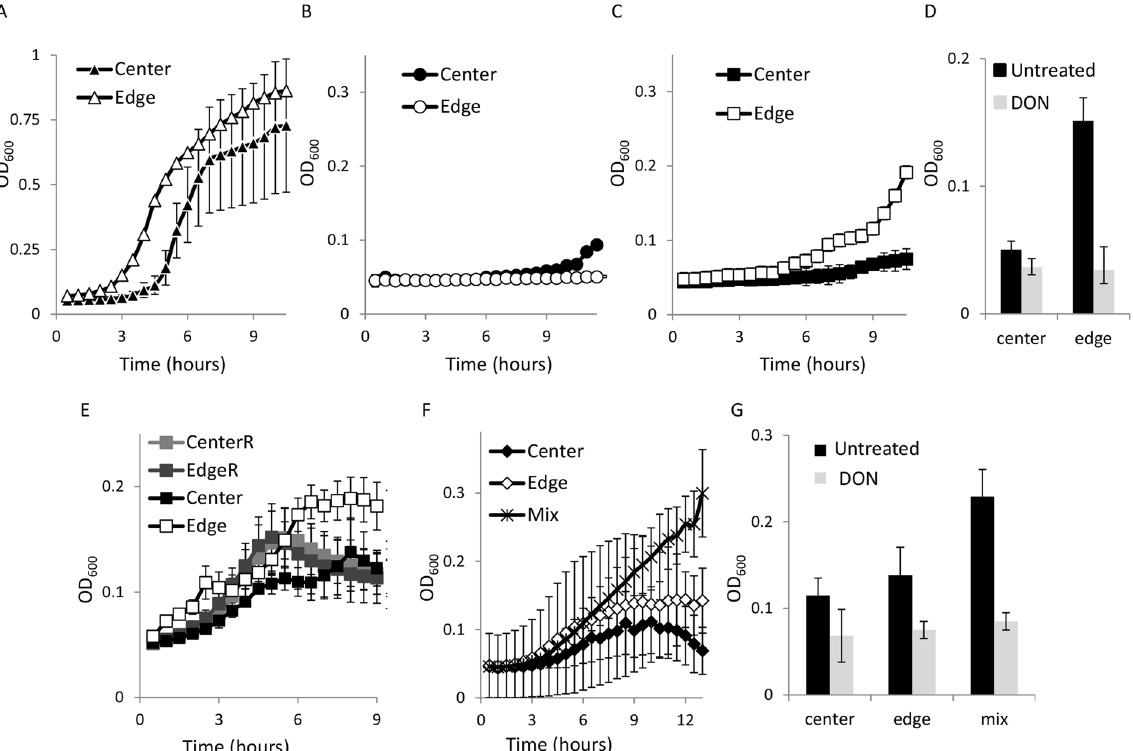
Figure 4. Spatial adaptation of biofilm cells to glutamate utilization. ( A – C ) Cells were harvested from developed biofilms indicated areas into PBS buffer, and gently sonicated. The cell counts were normalized by spectrophotometer . Harvested cells were inoculated in different media to assess planktonic growth by measuring OD 600 in a microplate reader. ( A ) Tryptic Soy Broth (TSB) rich medium (Difco). ( B ) MS salts applied with glutamate where it serves as the sole carbon and primary nitrogen source. ( C ) MS medium with ammonium chloride as a nitrogen source and sodium lactate as a carbon source (0.5%). When grown on glutamate or sodium-lactate, the periphery (edge) samples differed from the center interior samples by P– values < 0.0001 and < 0.001 respectively by a two tailed t-test. Results are an average of a single experiment performed with five independent technical repeats. Errors bars represent the corresponding standard deviations. The experiment is a representative experiment of three independent repeats. When grown in non- limiting medium for glutamate, the periphery (edge) samples and center samples were not significantly different from each other (p-Value > 0.1). ( D – F ) Biofilm cells were harvested from the periphery [edge] or interior [center] into MS salts as follows: ( D ) Cells were grown with glutamate as the nitrogen source and either with or without DON (0.1 µ M) for 10 hours. The culture grown either with or without DON differed from each other by a p-value < 0.005. The results are an average of two independent experiments performed with 10 technical repeats. The results are the average for three independent experiments performed with triplicates. Errors bars represent the corresponding standard deviations. ( E ) MS salts applied with glutamate where it serves as the sole carbon and primary nitrogen source. Cells were either inoculated directly from different zones of the biofilm as in B, or recovered for 4 hours in LB and diluted 1:100 in the glutamate-based medium (labeled as EdgeR and CenterR for their independent sources). The results are an average of three technical triplicates per three independent colonies. Errors bars represent the corresponding standard deviations between the colonies. Shown is a representative experiment out of three independent repeats. No significant difference in growth was observed in cells recovered from the edge and center and recovered in LB (P = 0.6004). Cells harvested directly from the center and edges differed significantly in their growth (P < 0.0005). ( F ) Cells harvested from the edge and the centers were mixed in a 1:1 ratio [mixture]. The cells were grown in a biofilm medium with glutamate as the nitrogen source, and sodium lactate as the carbon source. The mixed samples differed from the other samples by a p-value < 0.001. The results show the average and standard deviation of two independent experiments performed with 10 technical repeats, normalized by spectrophotometer. Equal number of cells taken from the periphery [edge], interior [center] or a 1:1 mixture of both the edge and the center, and grown in a biofilm medium with glutamate as the nitrogen source, and sodium lactate as the carbon source. The mixed samples differed from the other samples by a p-Value < 0.01. ( G ) The cells were grown in a biofilm medium with glutamate as the nitrogen source, and sodium lactate as the carbon source with or without DON (0.1 µ M). The mixed samples grown without DON differed from the other samples by a p-Value < 0.05. The edges and mixed samples grown with or without DON differed from each other by a p-value < 0.005. The results are an average of two independent experiments performed with 10 technical repeats. Errors bars represent the corresponding standard